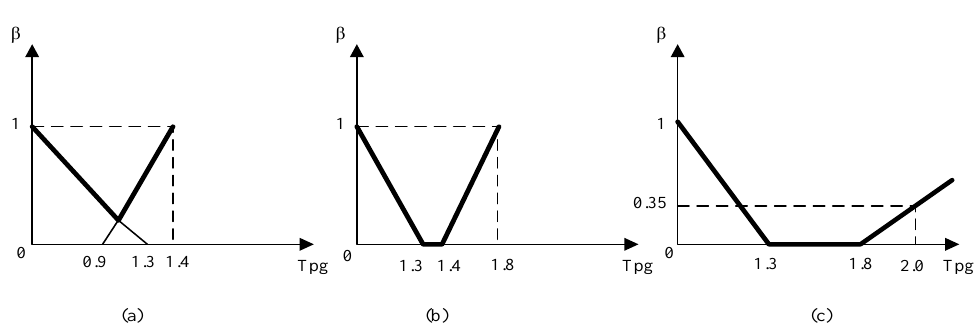
Figure 11. The dependence of the share of expenditures on installation of heat-saving windows and balcony doors, which is reimbursed by the state from the rate of growth of prices for natural gas, provided that the value of the coefficient of coverage of household expenditures is: ( a ) ν = 1.2; ( b ) ν = 1.6; ( c ) ν = 2 (the graphs are based on the expression (28) according to Table 9).